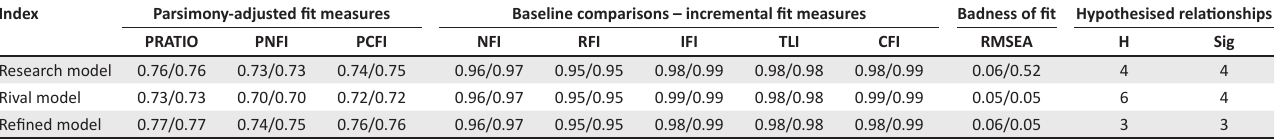
TABLE 7: Comparison of goodness-of-fit measures in purchase and sales business relationships.